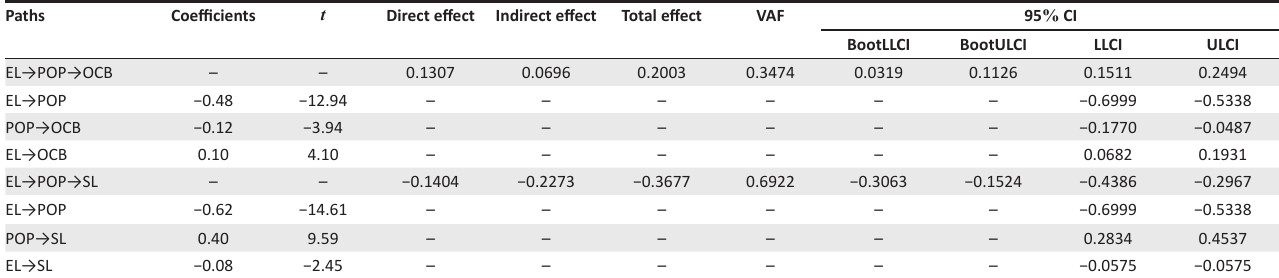
TABLE 6: Model mediation analyses. Paths